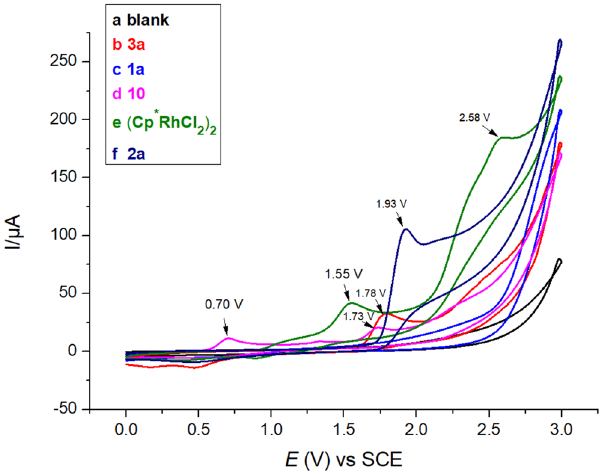
Fig. 6 Cyclic voltametric study. Cyclic voltammograms recorded on a Pt electrode (area = 0.03cm 2 ) with a scan rate of 100mVs − 1 : a MeCN containing 0.1M n -Bu 4 NPF 6 ; b MeCN containing 0.1M n -Bu 4 NPF 6 , after addition of 4mM 3a ; c MeCN containing 0.1M n -Bu 4 NPF 6 , after addition of 4